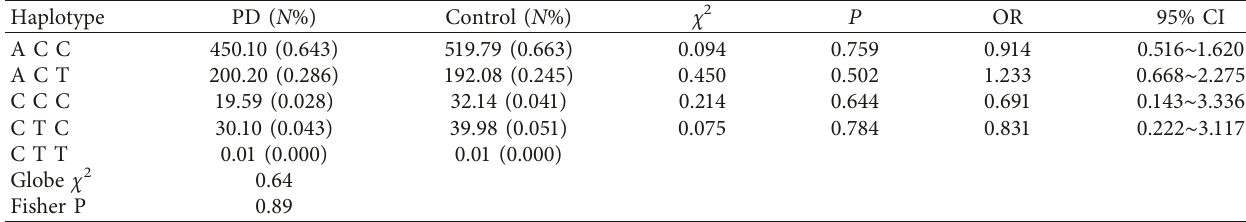
Table 4: SLC6A3 haplotype frequency distribution in the Han